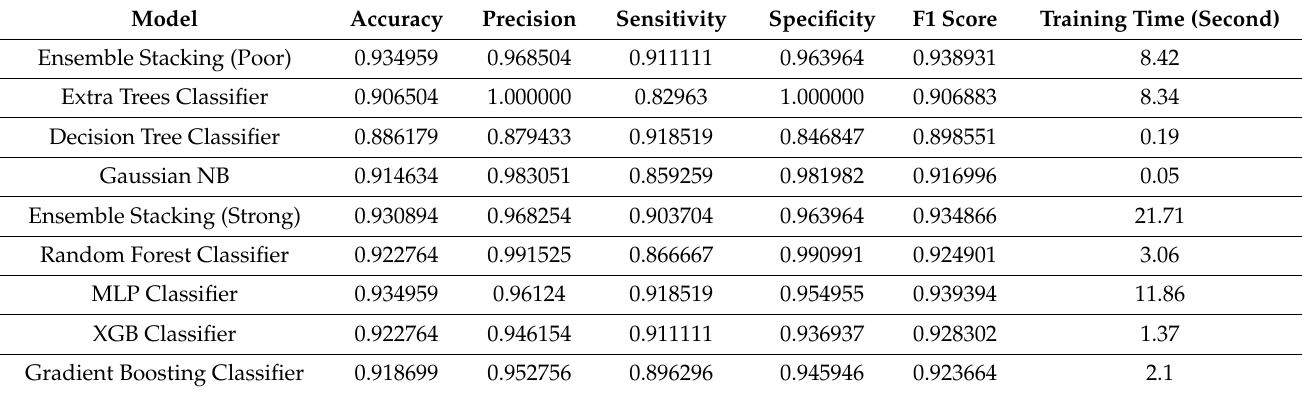
Table 4. Credit card fraud detection using ensemble stacking.